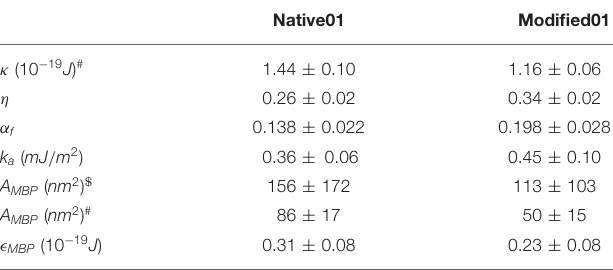
Frontiers in Chemistry |